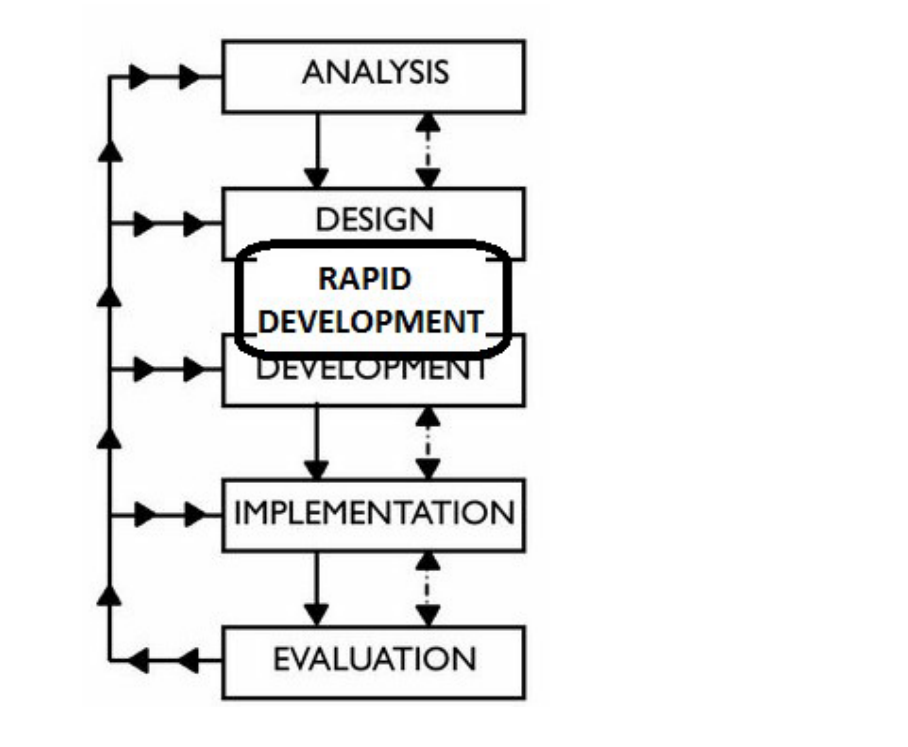
Figure 2 . The instructional design model adopted in R EVIT . Figure modified from Hodell (1994, p.